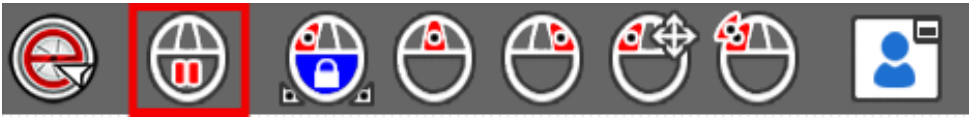
Figure 2. Software eViacam Cursor Events